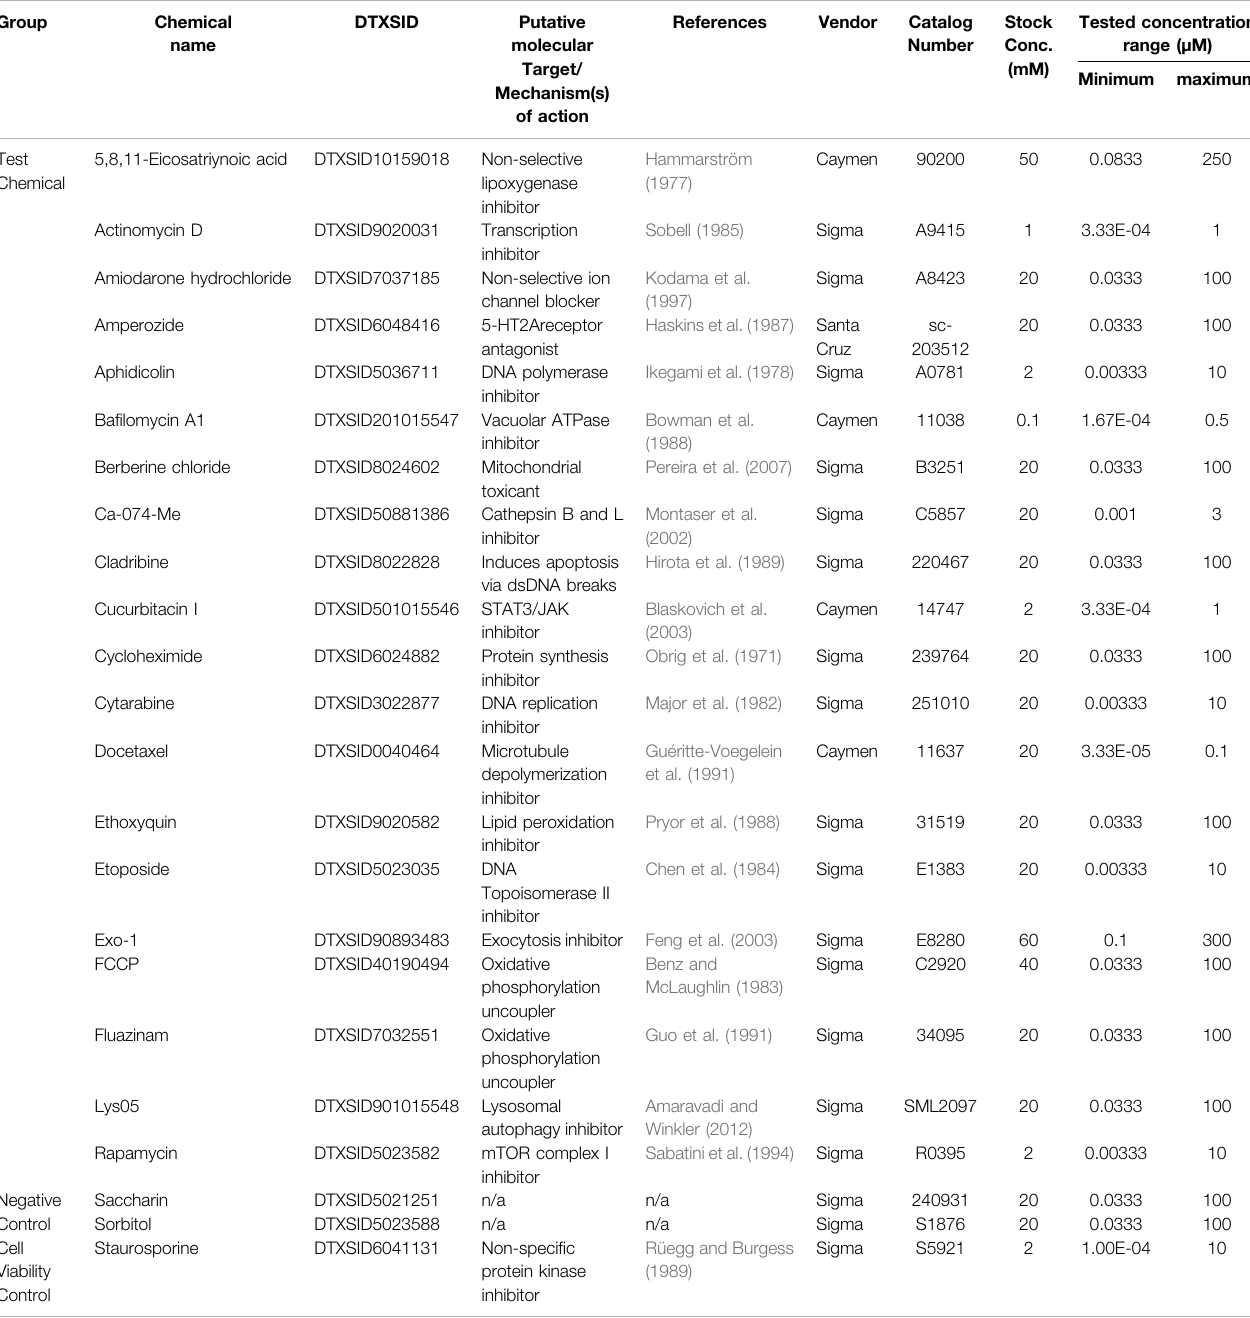
TABLE 1 | Reference chemical set utilized to identify appropriate in-plate assay